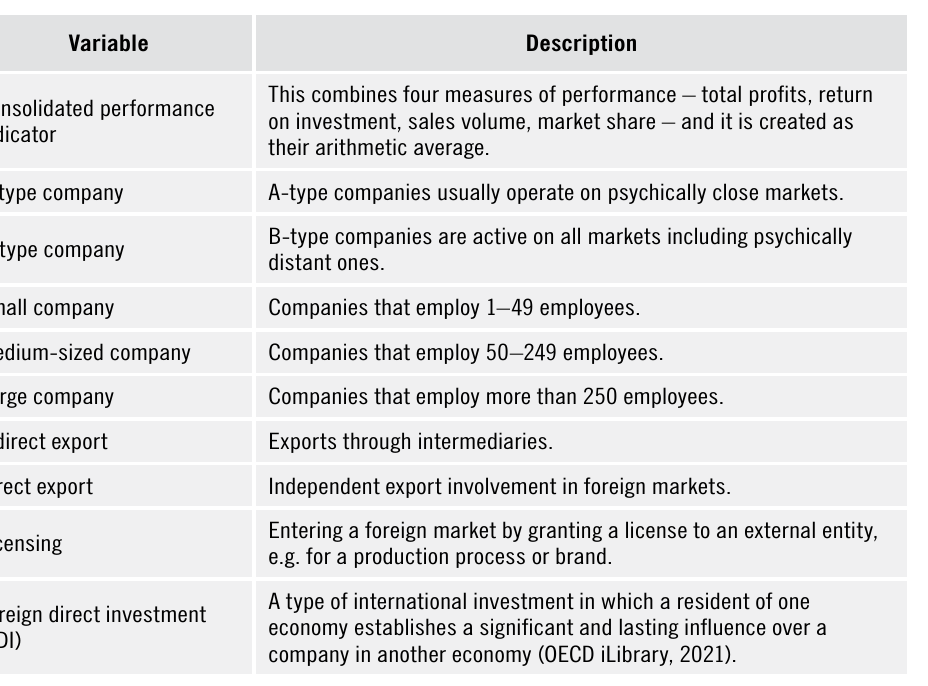
Table 1. Types of variables and categories used in the